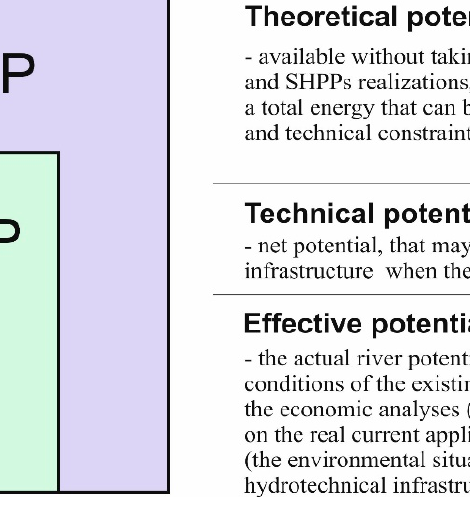
Figure 1. Terminology and basic methodology of potentials assessment [7] modified.